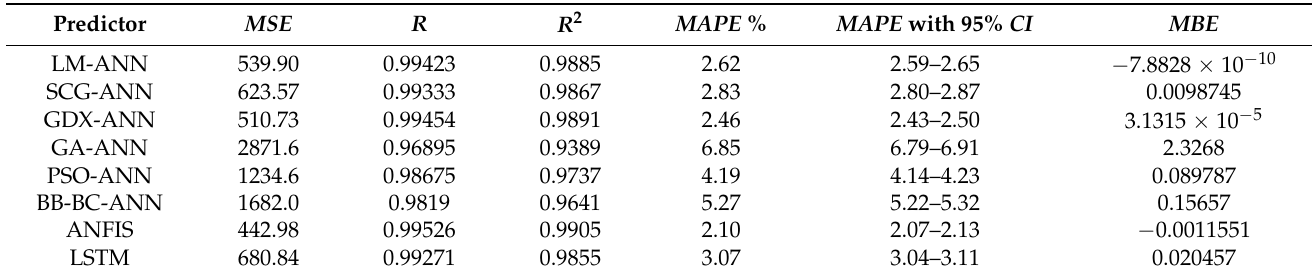
Table 2. Results of the training